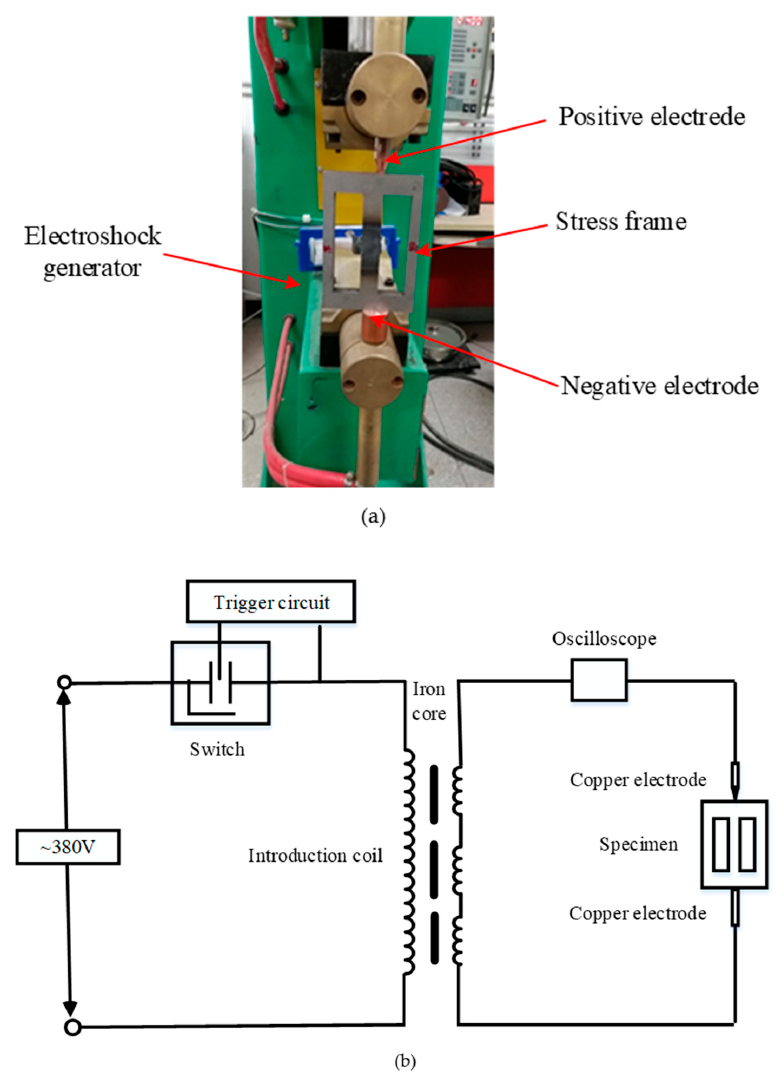
Figure 3. ( a ) Specimen treated with EST; ( b ) Schematic of the EST device. Table 3. EST processing parameters.